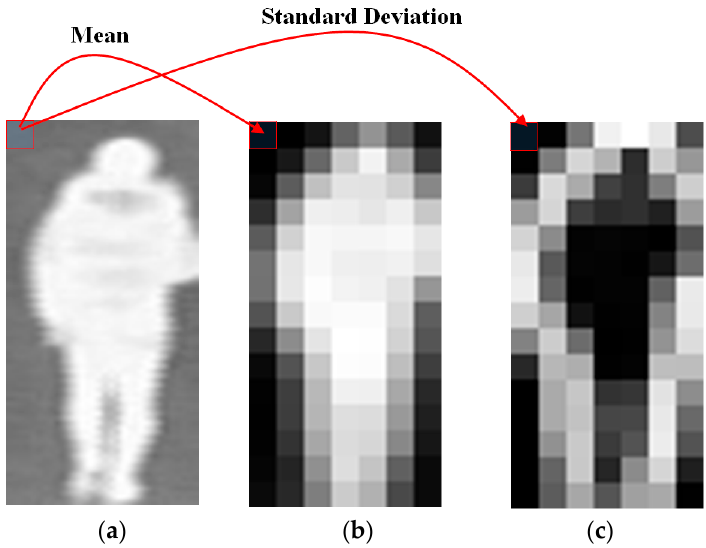
Figure 3. Example of mean and standard deviation maps obtained from a thermal image: ( a ) a thermal image with background (low illumination regions) and foreground (high illumination regions); ( b ) MEAN map; and ( c ) STD map.